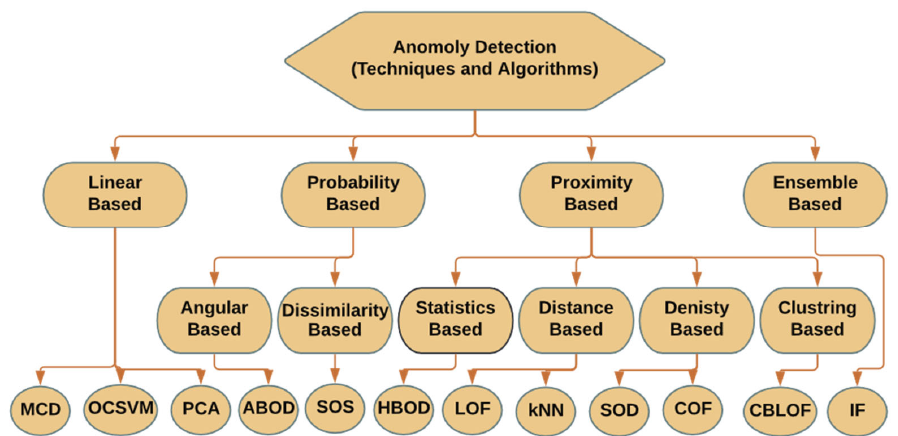
Figure 2. A Summary of the bases of anomaly detection algorithms.